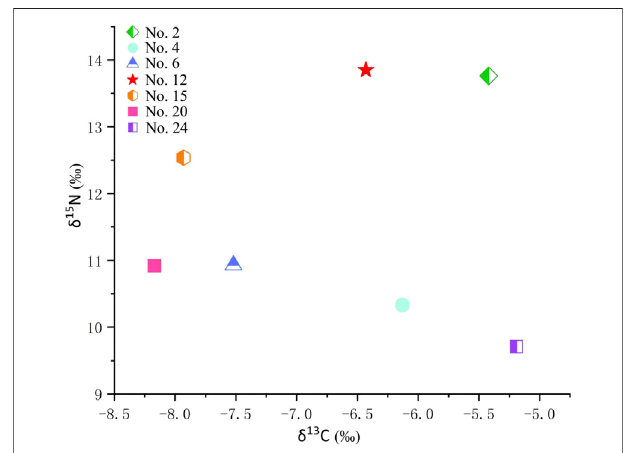
FIGURE 3 | Scatter diagram for δ 13 C and δ 15 N values of the seven human tooth samples from the Lajia site.